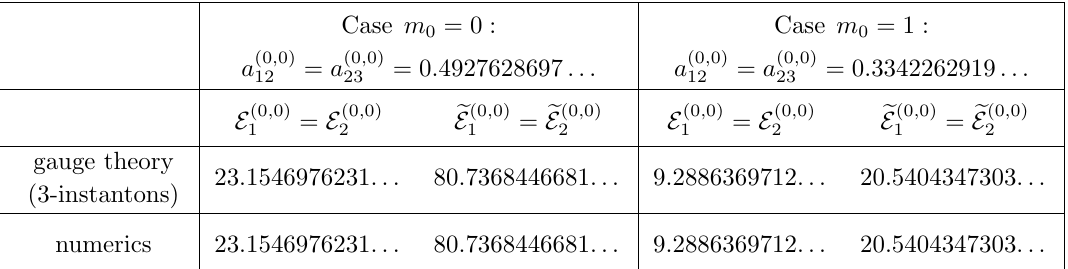
Table 6. 3-particle relativistic Toda energies and dual energies for the ground state ( n 12 ; n 23 ) = (0 ; 0) at ! 1 = 1 p , ! 2 = 1 and m 0 = 0 or m 0 = 2